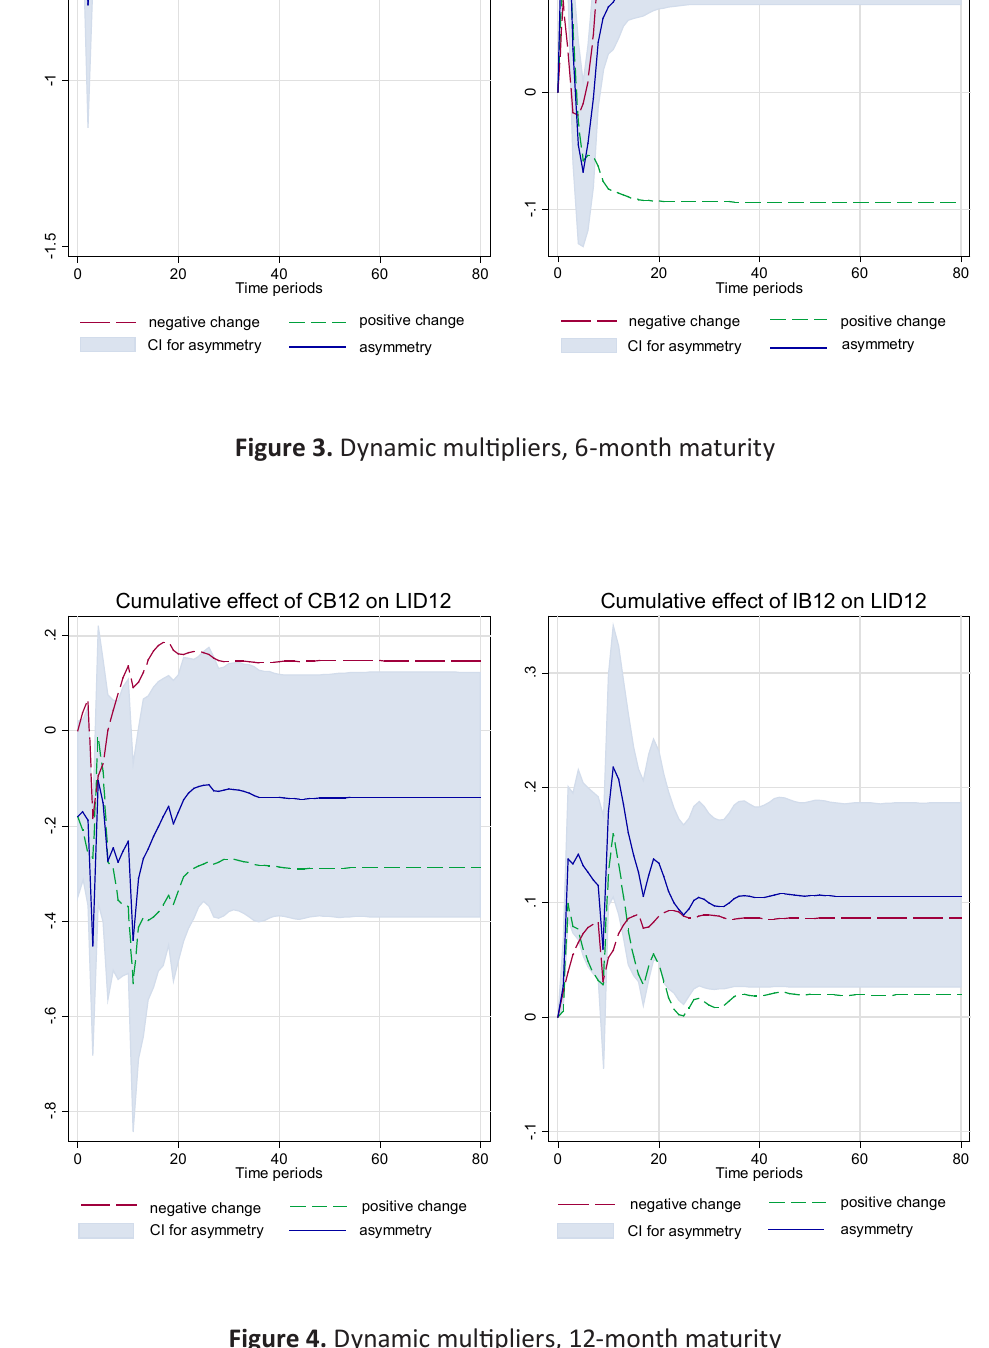
Figure 4. Dynamic multipliers, 12-month